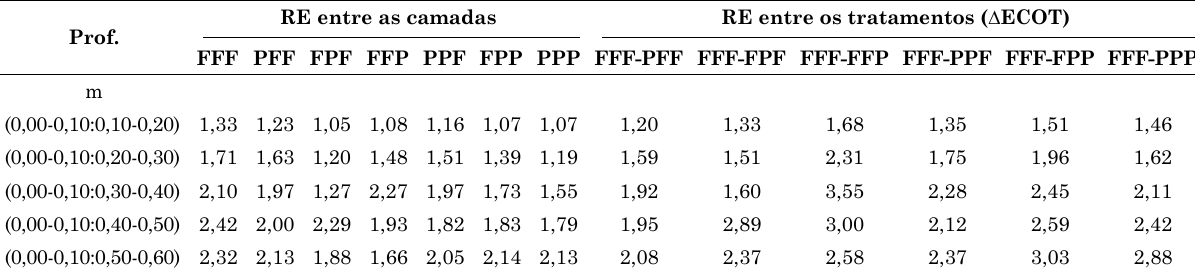
FFF: uso com floresta a mais de 70 anos; FPF: área ocupada nos últimos 25 anos por floresta, antecedida por um período de 25 anos por pastagem e anteriormente por floresta; PFF: uso com florestas nos últimos 50 anos e pastagem no período anterior a 1957; PPF: área ocupada nos últimos 25 anos com floresta, antecedida por pastagem; PPP: uso com pastagem a mais de 70 anos; FFP: uso com pastagem nos últimos 25 anos; e FPP: uso com pastagem nos últimos 25